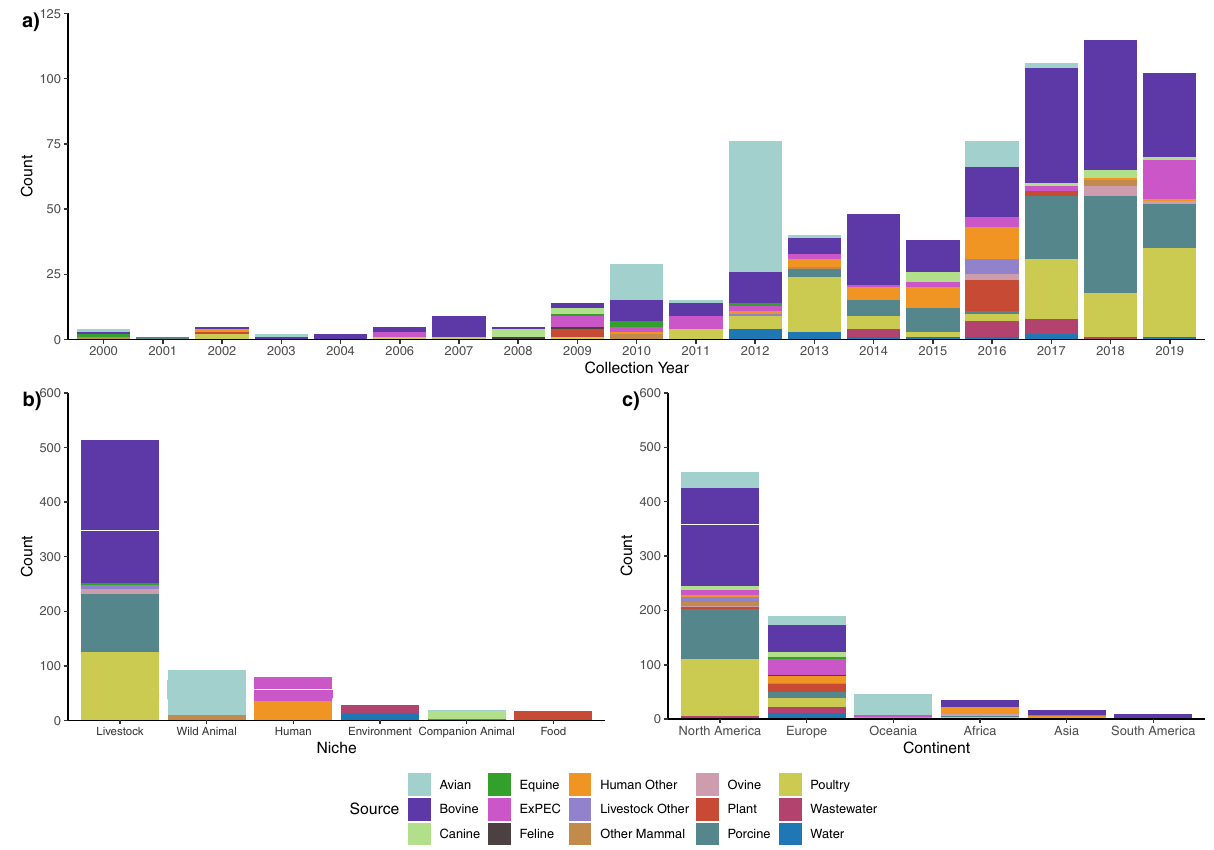
Fig. 1 ST58 genome collection metadata. Summary of metadata of 752 E. coli ST58 strains strati fi ed by source. a Collection year (2000 – 2019; for full year distribution see Fig. S1); b Niche; c